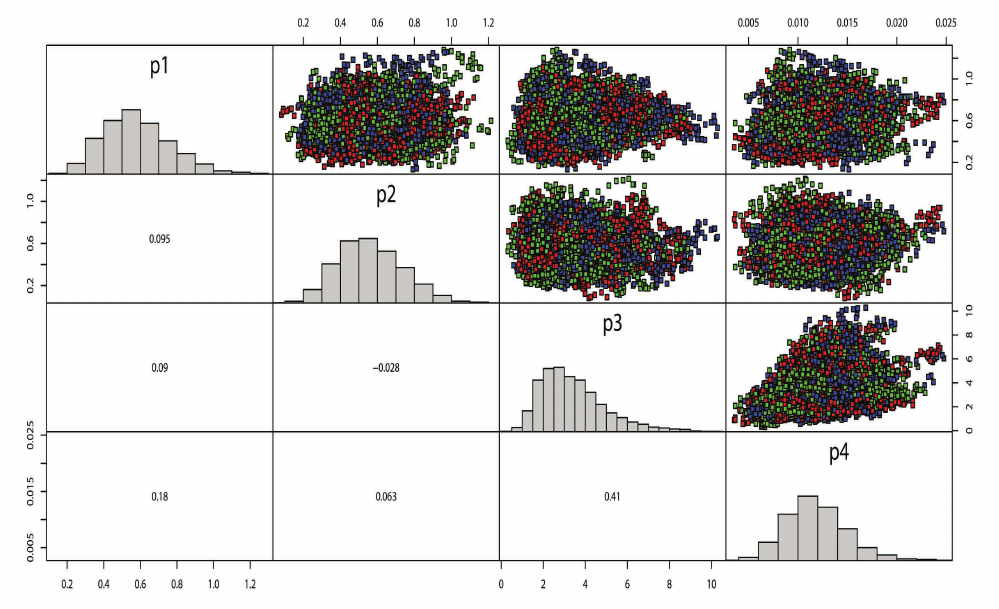
Figure 11. Pairs plot of the MCMC samples for parameter estimates of stress–strength for EED based on complete sample.